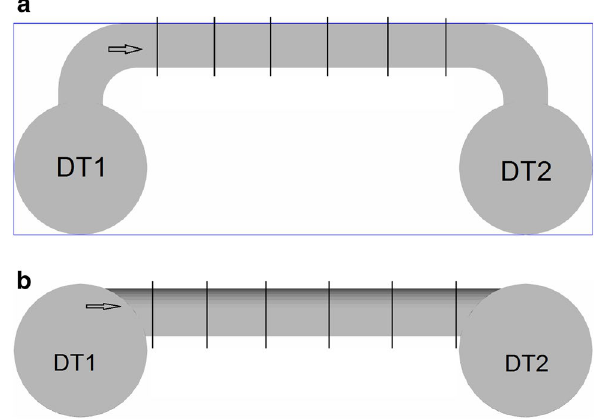
Fig. 10 Enhanced designs of the aeration gallery: a design no 1, b design no